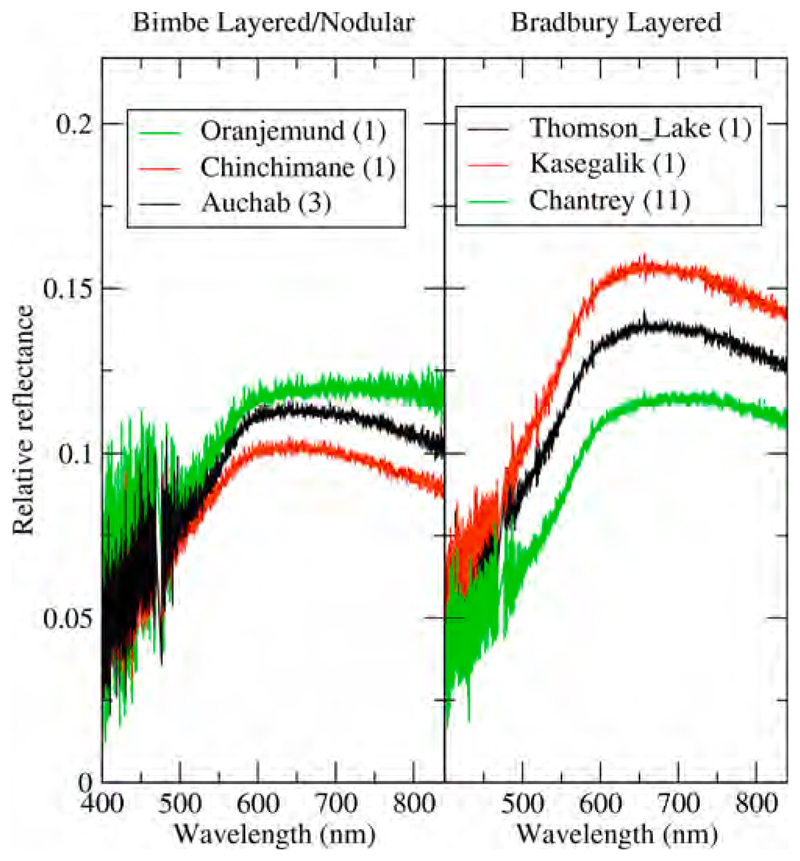
ChemCam relative reflectance spectra of representative samples of the Bimbe layered and nodular rocks, along with sample spectra from the Bradbury layered rocks. The Bimbe rocks show either flat near-infrared spectra or downturns that begin near 600 nm, whereas the Bradbury rocks have peak reflectance wavelengths near 650–675 nm. (For interpretation of the references to color in this figure legend, the reader is referred to the web version of this article.)